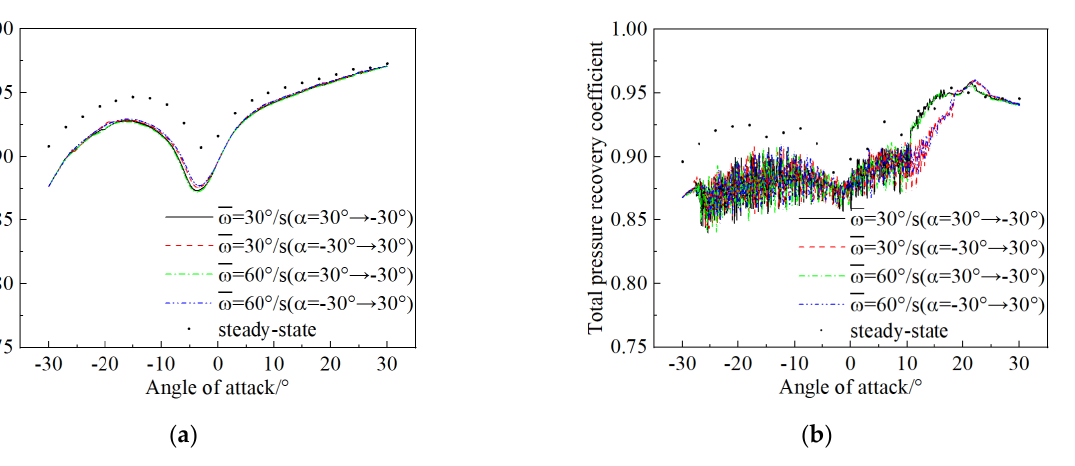
Figure 14. Total pressure recovery coefficient versus angle of attack.(a) Conventional submerged inlet ,(b) Distributed submerged inlet